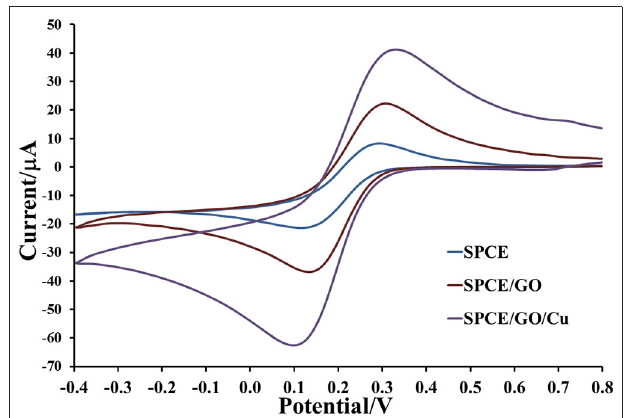
FIGURE 5 | Electrochemical responses for [Fe(CN) 6 ] 4 − / 3 − process at Cu(II)/GO-modified SPCE; (A) CVs and (B) related anodic and cathodic peak currents at different scan